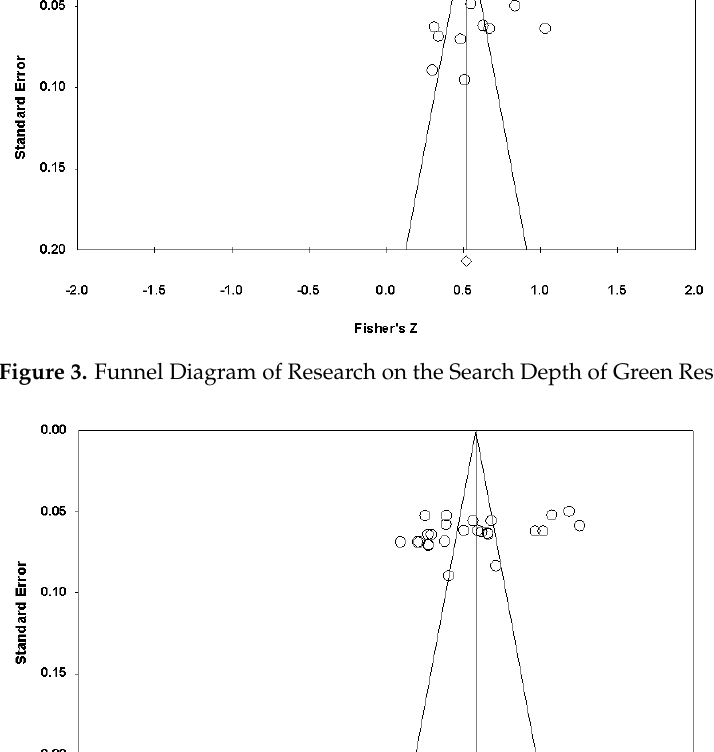
Figure 2. Funnel Diagram of Research on the Search Breadth of Green Resources.